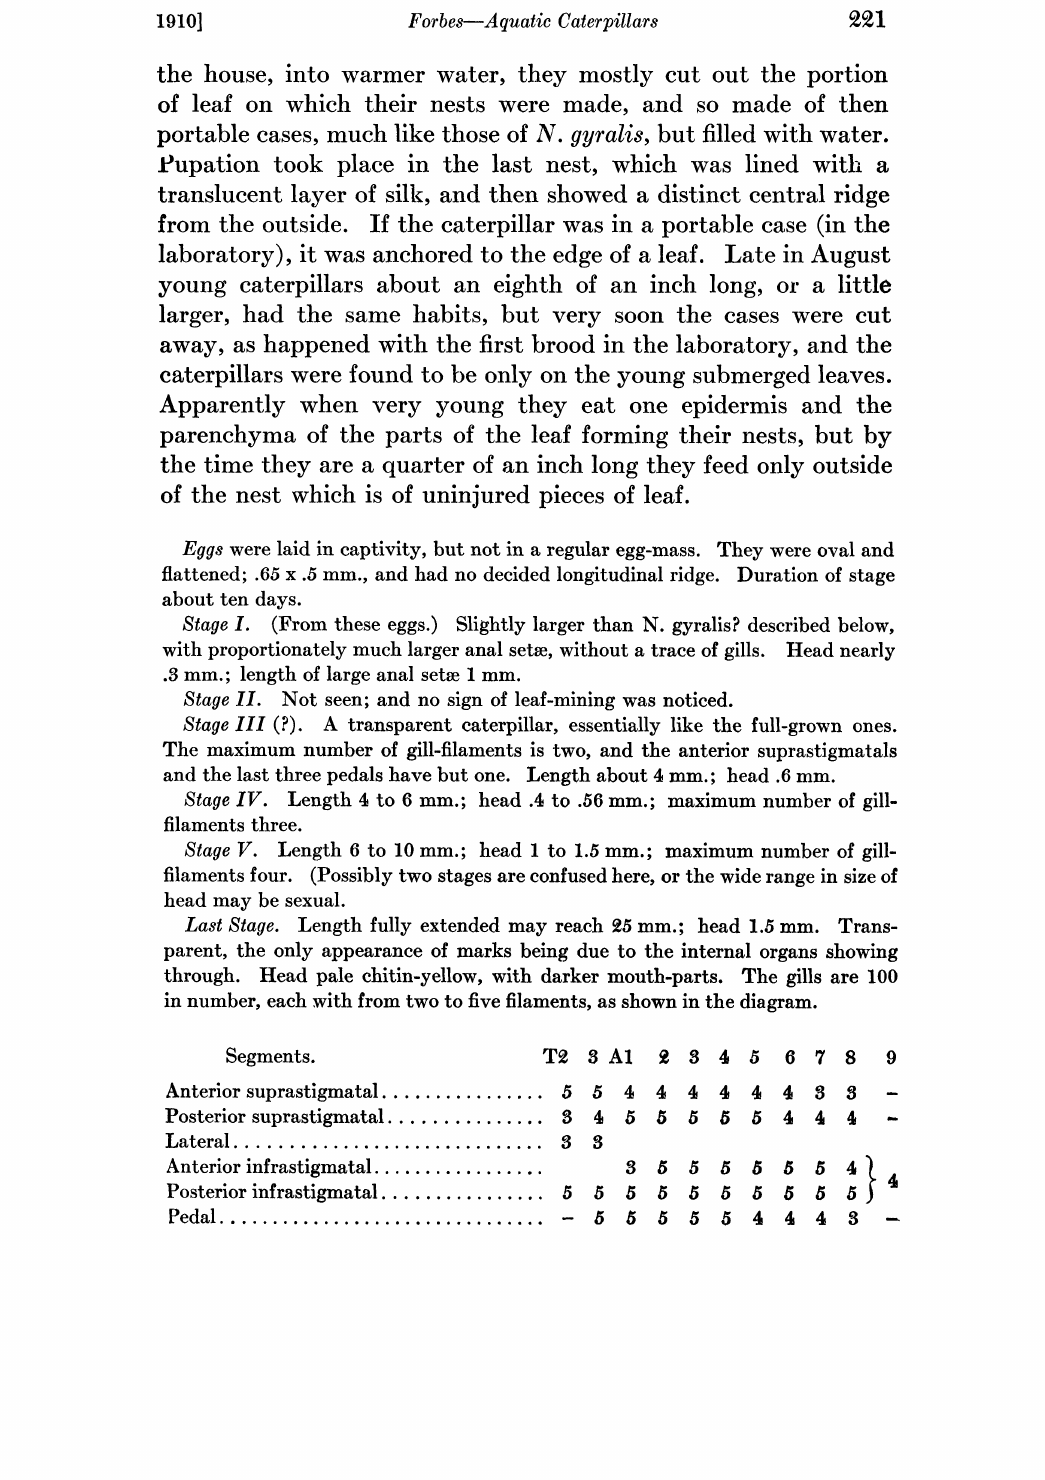
Anterior suprastigmatal Posterior suprastigmatal Lateral Anterior infrastigmatal Posterior